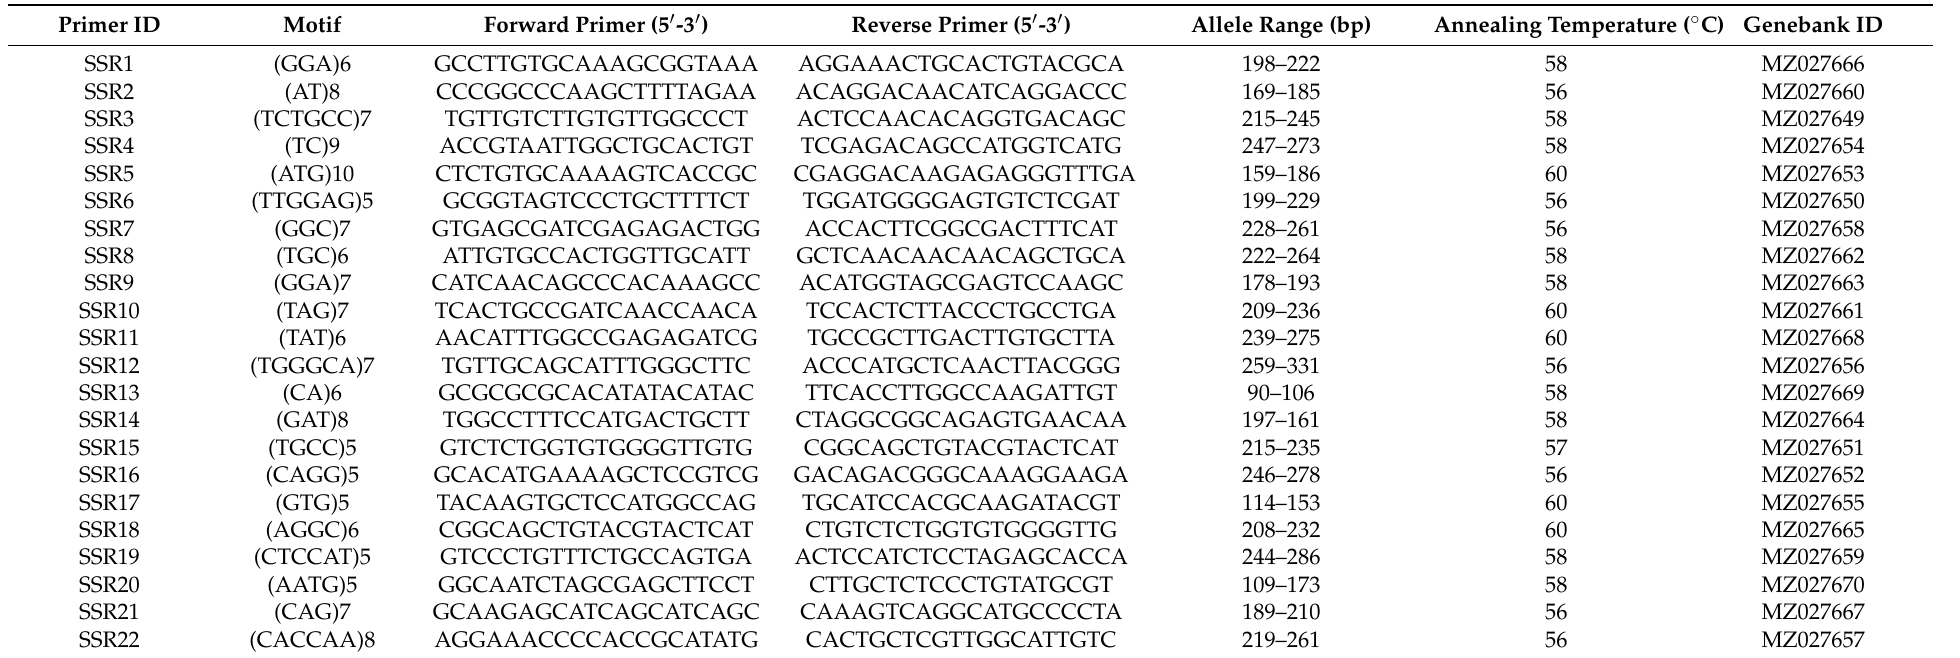
Table 2. Characterization of novel 22 EST-SSR primers pairs in Chinese